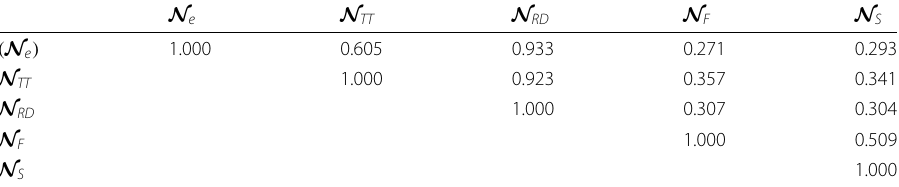
Table 3 Correlation between edge weights based on distance metrics N x N e